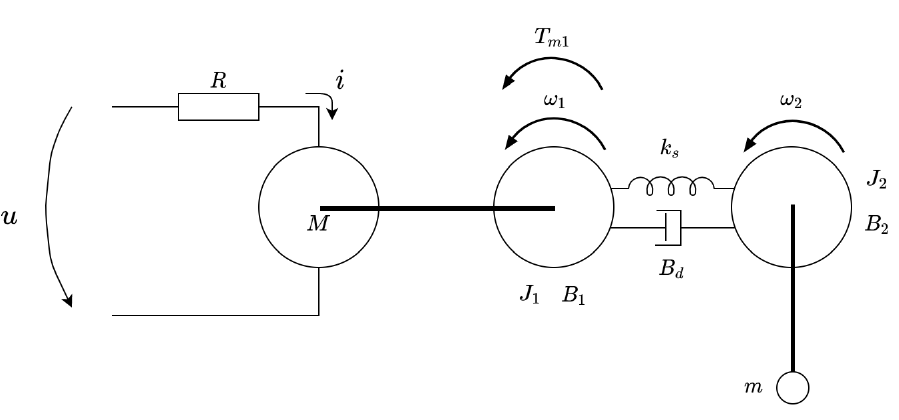
Figure 6. Non-Rigid joint conceptual